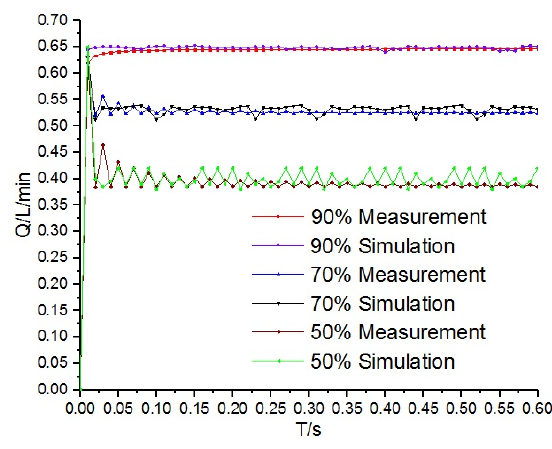
Figure 9. Simulation and test contrast curves.